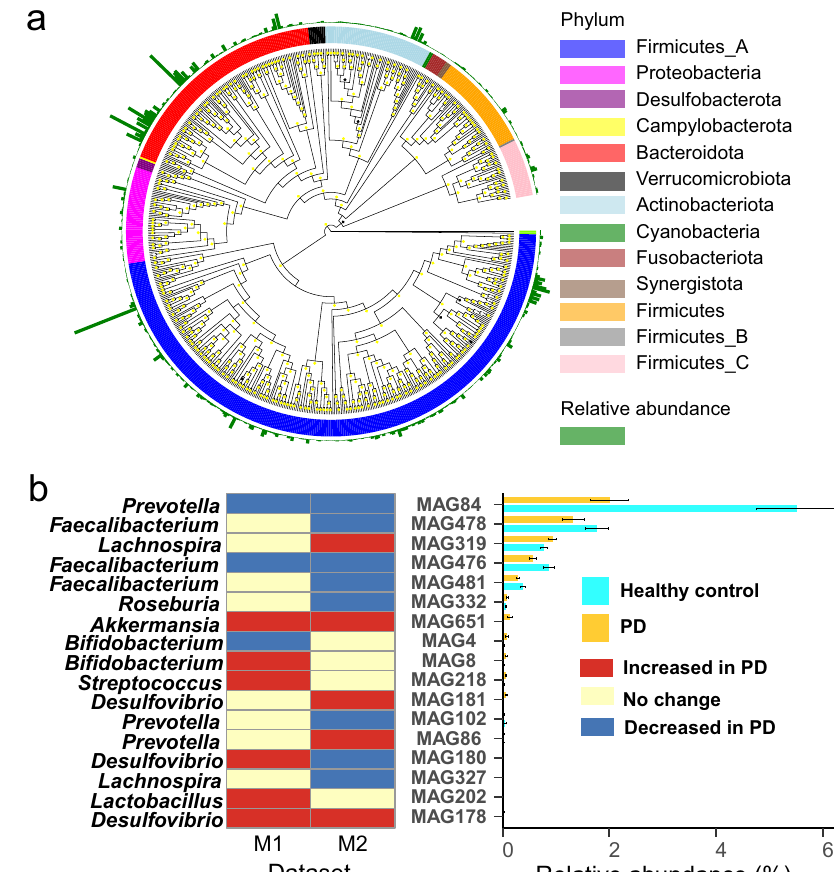
Fig. 5 Metagenome-assembled genomes analysis. a The maximum-likelihood phylogenetic tree of the 654 metagenome-assembled genomes (MAGs). The tree was based on the 120 bacterial (122 archaeal) concatenated ribosomal proteins, colored by phyla. Bootstrap values were calculated based on 1000 replicates, and the value higher than 80% were marked in yellow. b The 17 MAGs with signi fi cant differences between Parkinson ’ s disease (PD) and healthy groups in at least one Metagenomic dataset (M1 – 2). The error bar represents the standard error of the mean relative abundance in each bar